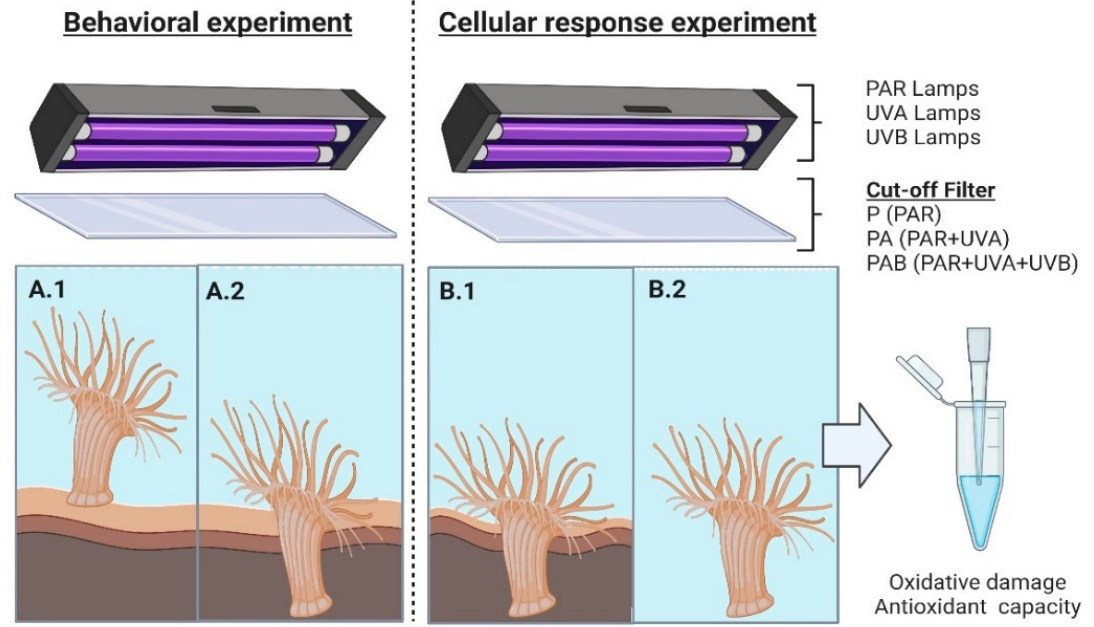
Figure 2. Experimental setup for behavioral (( A.1 ) initial time/( A.2 ) final time) and cellular responses (( B.1 ) with sediment/( B.2 ) without sediment) in adults and juveniles of the sea anemone A. hermaphroditica exposed to different radiation conditions generated by a combination of fluorescent lamps (PAR, UVA and UVB) and cut-off filters (P: PAR, PA: PAR + UVA and PAB: PAR + UVA + UVB). Figure created using BioRender.com (accessed on 9 August 2022).